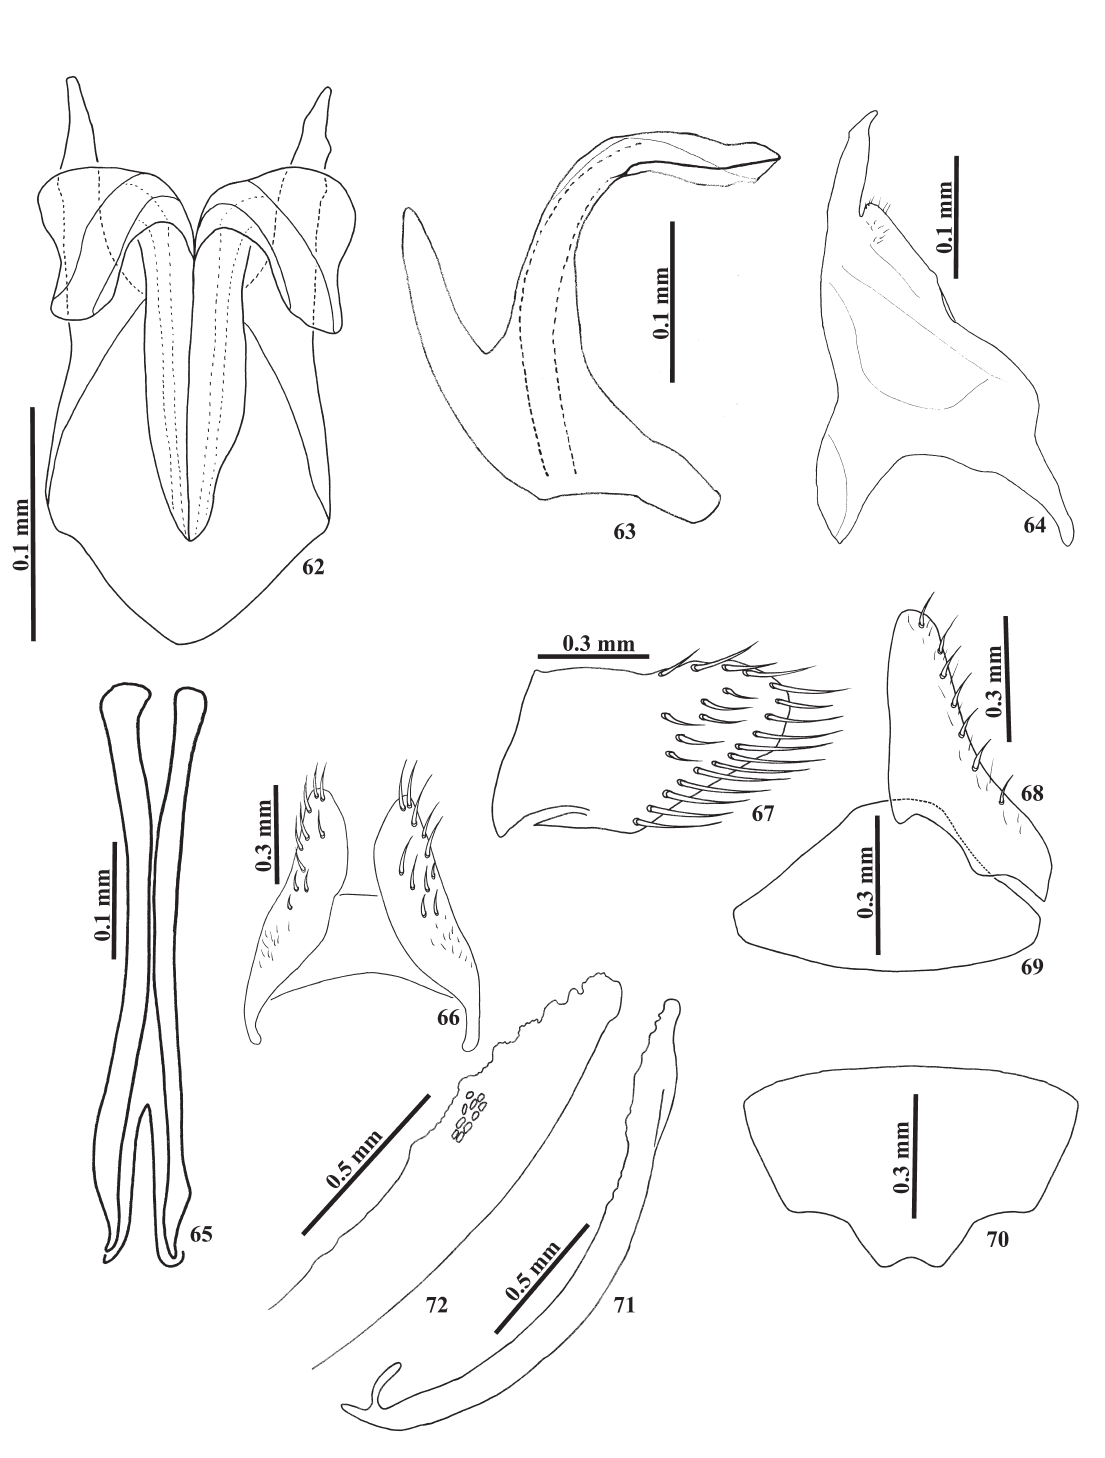
Figs 62–72 . Oshaibahus zizyphi (Bergevin, 1922) gen. et comb. nov. 62 . Aedeagus dorsal view. 63 . Aedeagus lateral view. 64 . Style. 65 . Connective. 66 . Ventral view of pygofer. 67 . Lateral view of pygofer. 68 . Subgenital plate. 69 . Valve. 70 . ♀ 7 th sternite. 71 – 72 . ♀